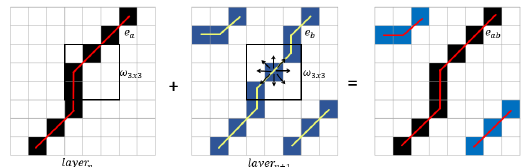
Figure 1. Effects of merging layers with edges e a and e b that have shifted edge positions. The resulting edge e ab has an extra double edge created which results in noisy edges.